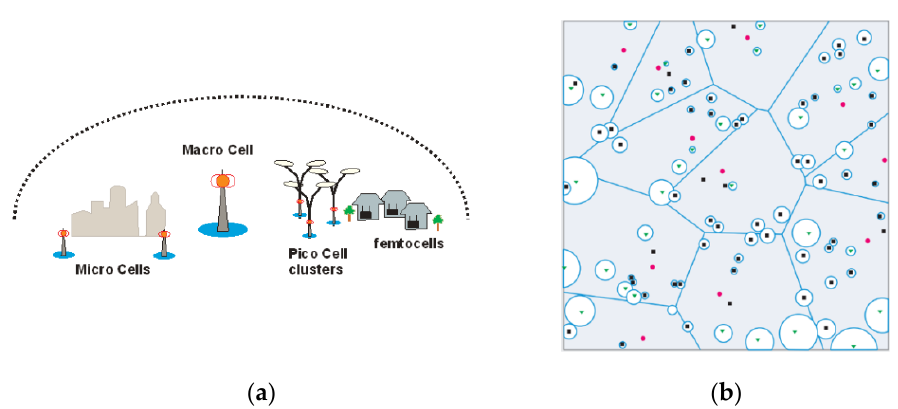
Figure 1. Simplified presentations of an exemplar Heterogeneous Cellular Network (HCN), also commonly referred to as HetNet, (HetNet); ( a ) multiple-standard radio access HetNet; ( b ) 3-tier HetNet coverage with blue lines as service zones’ boundaries, and red spots, green triangles, and black squares as macro-cells, pico-cells, and femto-cells, respectively.